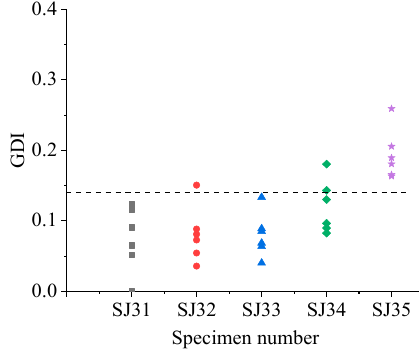
Figure 13. GDI of specimens in the SJ3 group.